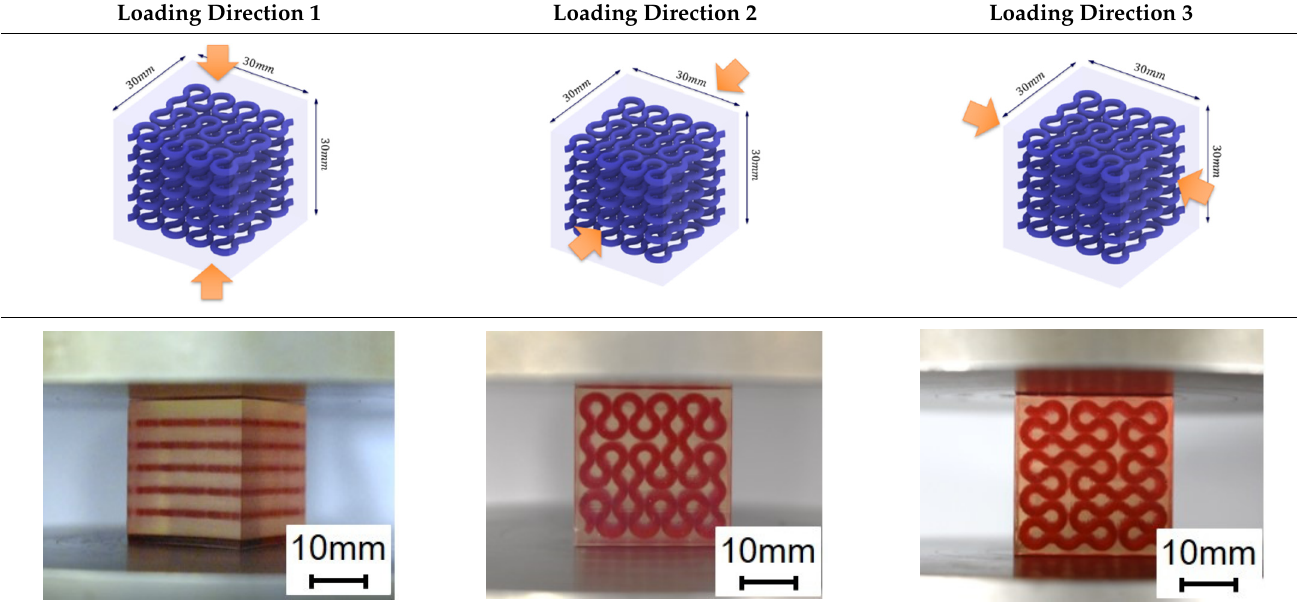
cube; ( f ) plan views of four different hybrid structures showing the first order reinforcement with a reinforcement diameter of 2.8 mm and 1.156 mm for all three second order designs; ( g ) pictures of 3D printed samples (from left to right, corresponds to case 1 to case 4, respectively).